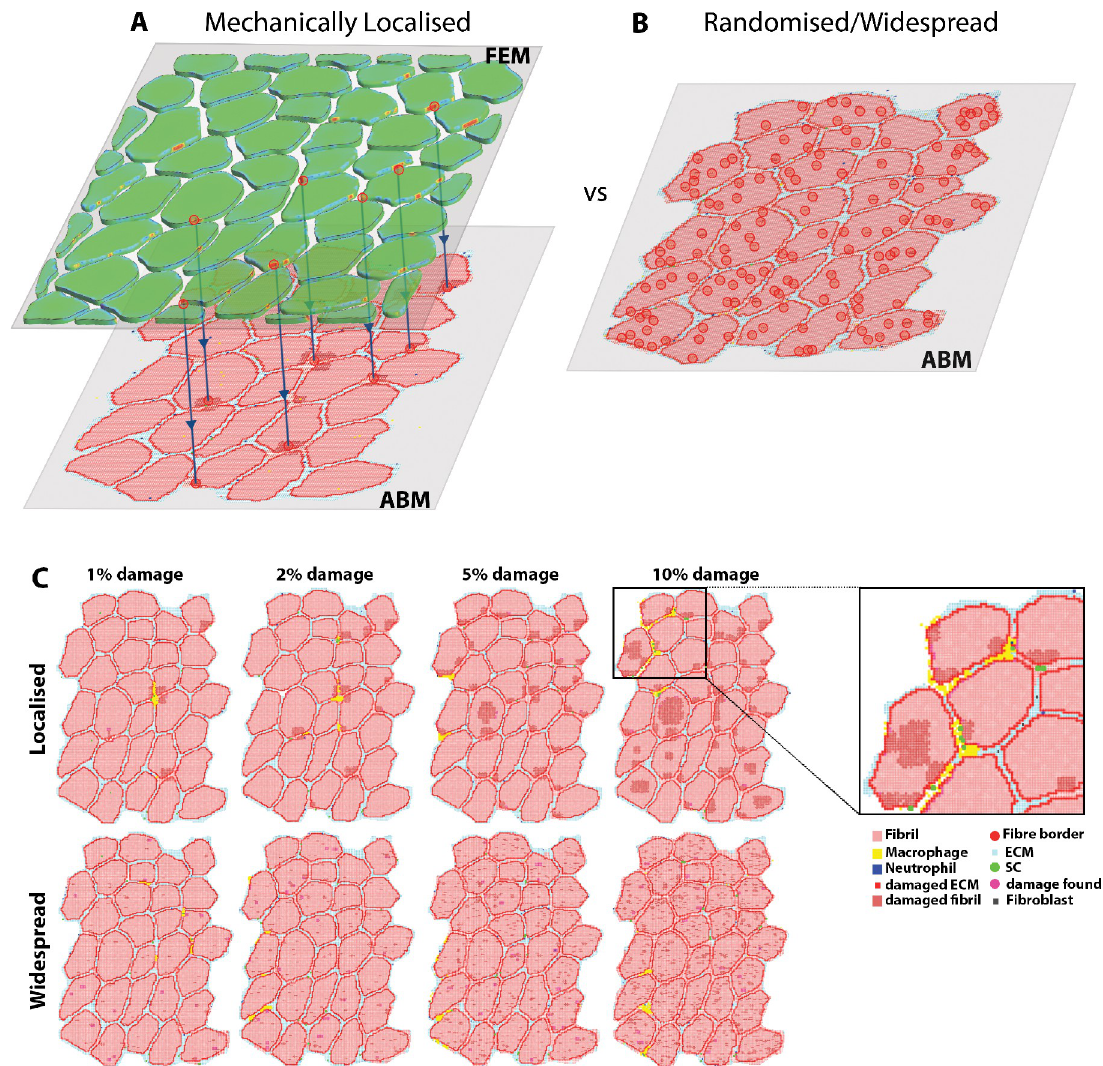
Fig 1. Methods of strain input for the agent-based model. (A) Mechanically localised strain values from FEM of a muscle bundle were used to seed an ABM of muscle damage. This was compared to (B) widespread damage seeded by selecting random muscle fibrils in the ABM and labelling them as damaged in the simulation. (C) Visualisation of the damage in localised vs widespread agent-based simulations, zoom inset displays the agents used in this ABM.